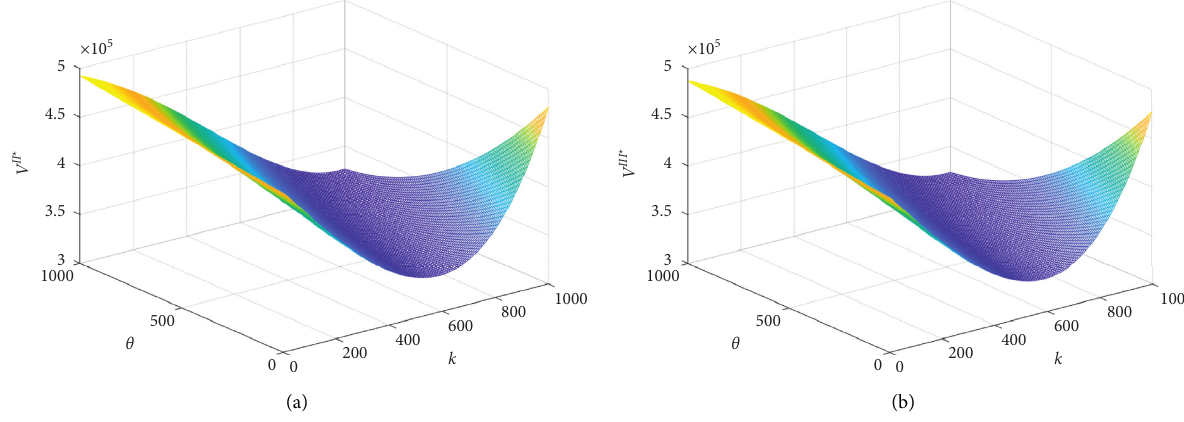
Figure 12: The effects of θ and k on profit of retailer. (a) V ΙΙ∗ (b) V ΙΙΙ∗ .